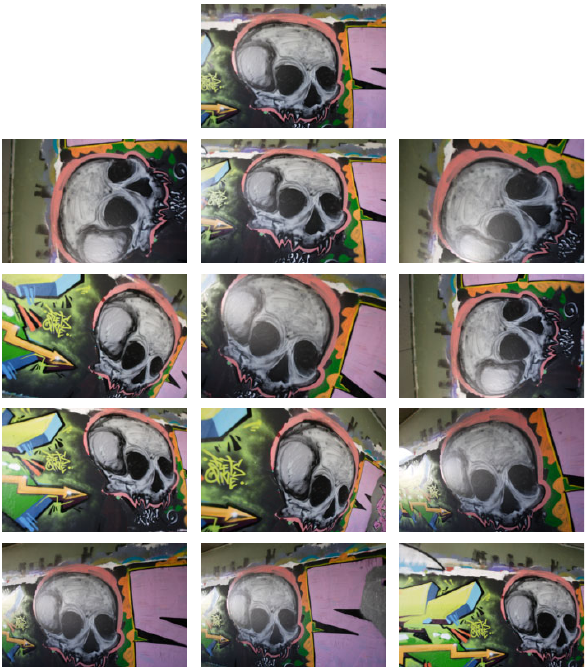
Figure 1. Image set 1 (the ‘fronto-parallel’ key frame is on